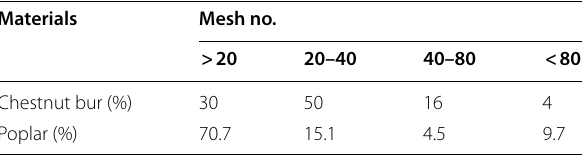
Table 1 Distribution of particle size of chestnut bur and poplar based on mesh analysis Materials